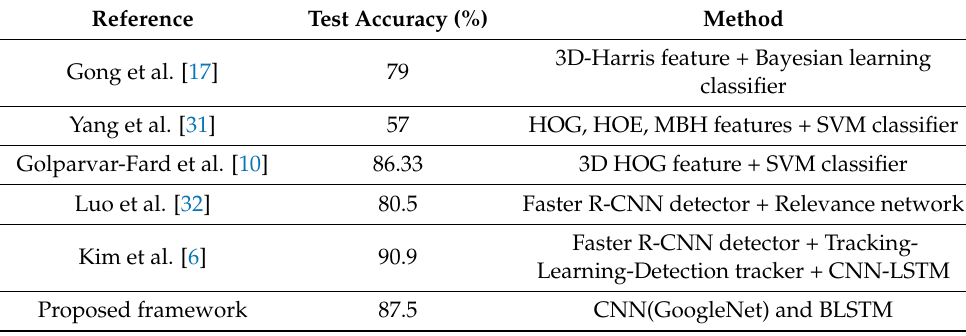
Table 6. Performance comparison with previous